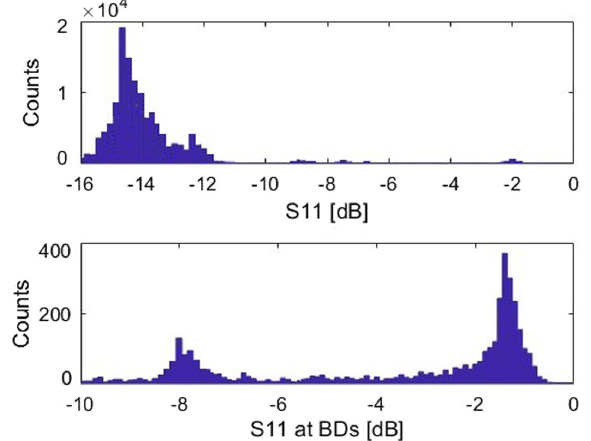
FIG. 11. S 11 histograms during normal pulses (top) and BD events (bottom) as a function of input reflection S 11 .